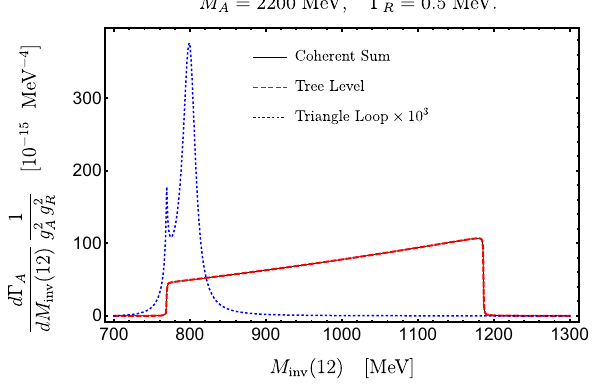
1 Fig. 9 d (cid:4) A asafunctionof M inv ( 12 ) with M A = 2200MeV dM inv ( 12 ) g 2 A g 2 R and (cid:4) R = 0 . 5 MeV. The dashed and solid lines are indistinguishable